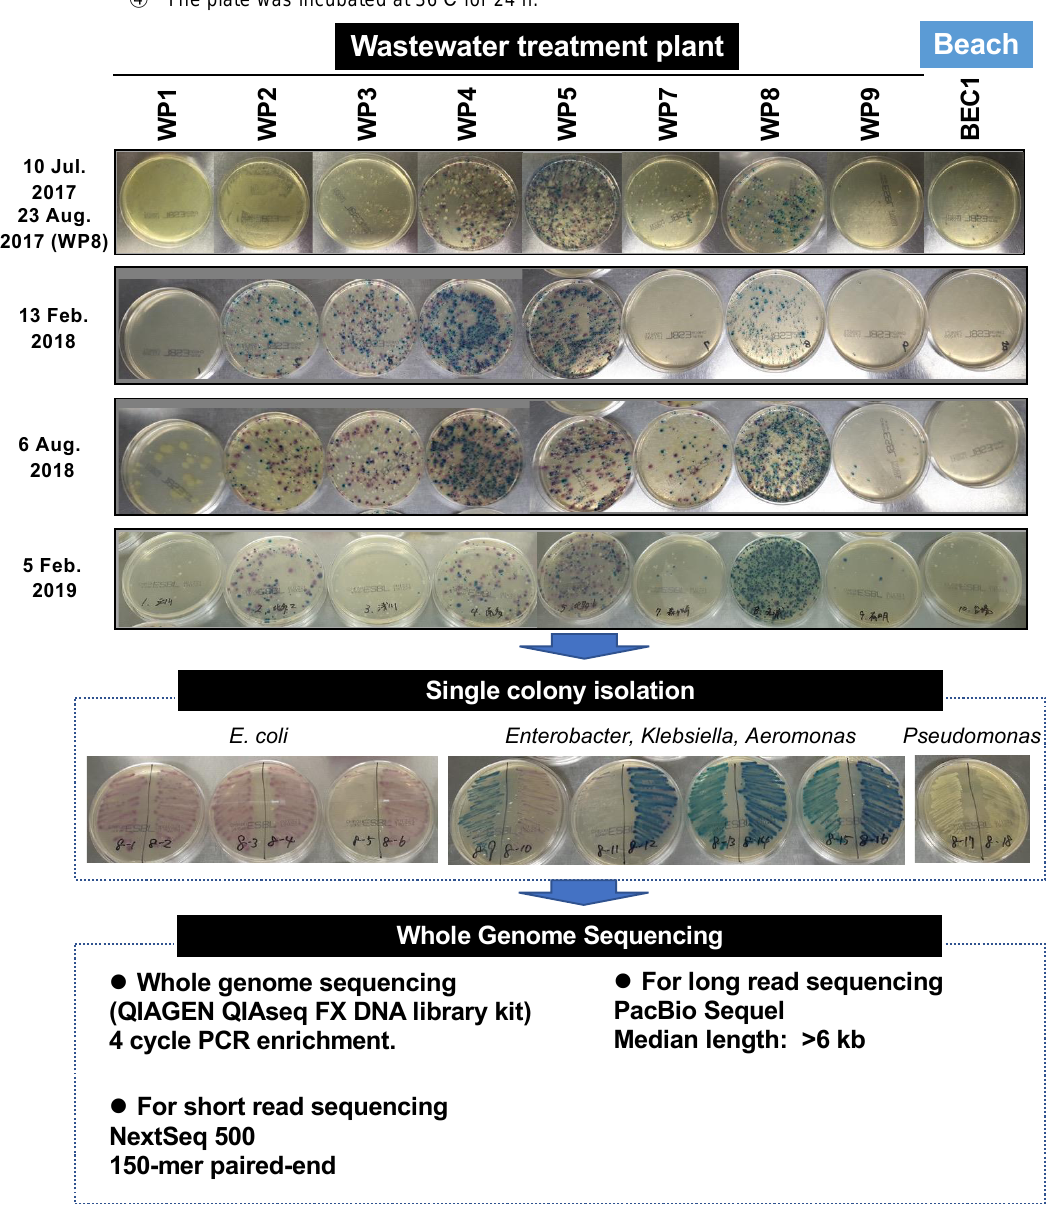
Figure 1. Experimental procedures to isolate potential ESBL-producing bacteria. Sewage effluent samples were collected from eight WWTPs (WP1–WP9, and WP6 was treated as missing numbers owing to incorrect sampling locations) along the Tama River and around the Tokyo Bay (Table S1). Surface water from a recreational beach (BEC1) was used as an environmental control sample. Sampling was conducted during the summer and winter seasons for 2 years between August 2017 and February 2019 (Table